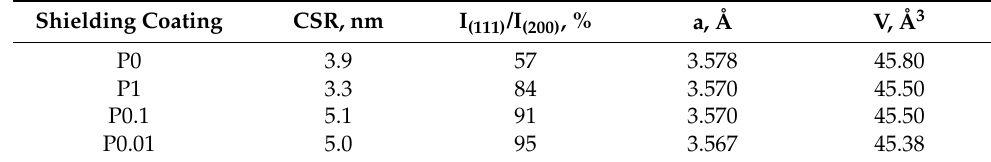
Table 2. Crystal structure parameters of FeNi shielding coatings obtained with different electrodepo- sition modes.